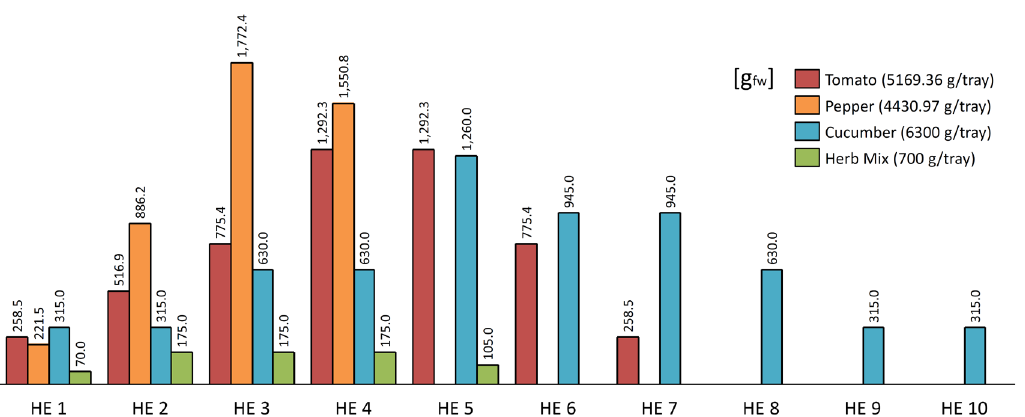
Figure 4: Distribution of edible biomass output in grams of fresh weight over defined harvest events, adapted from BVAD (Anderson et al. 2015) (with the exception of cucumber (Lattauschke 2004) and (Gitelson et al. 2003); The distribution pattern of harvest events (HE) focus- ses on the fruit crops, cucumber (blue), tomato (red), and pepper (orange). The crop type ‘herbs’ was also considered as a selective harvest event (green bars), although they were assigned to the vegetative crop category; the harvest distribution was estimated according to best horticulture practices as well as initial observations in the EDEN lab.